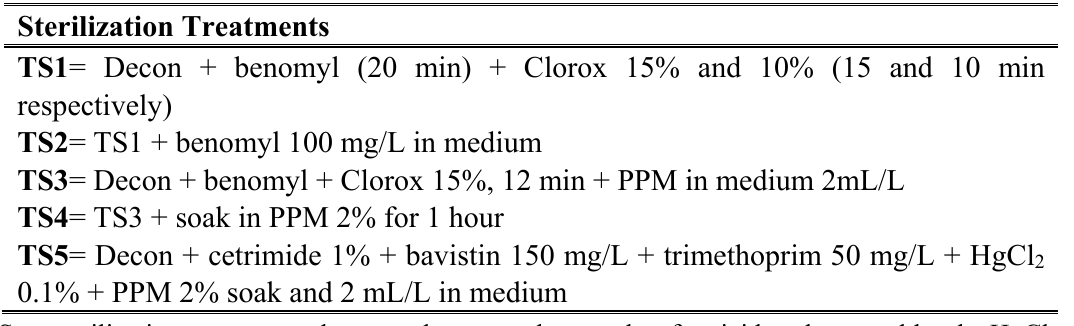
Table 1. Different treatments for sterilization of